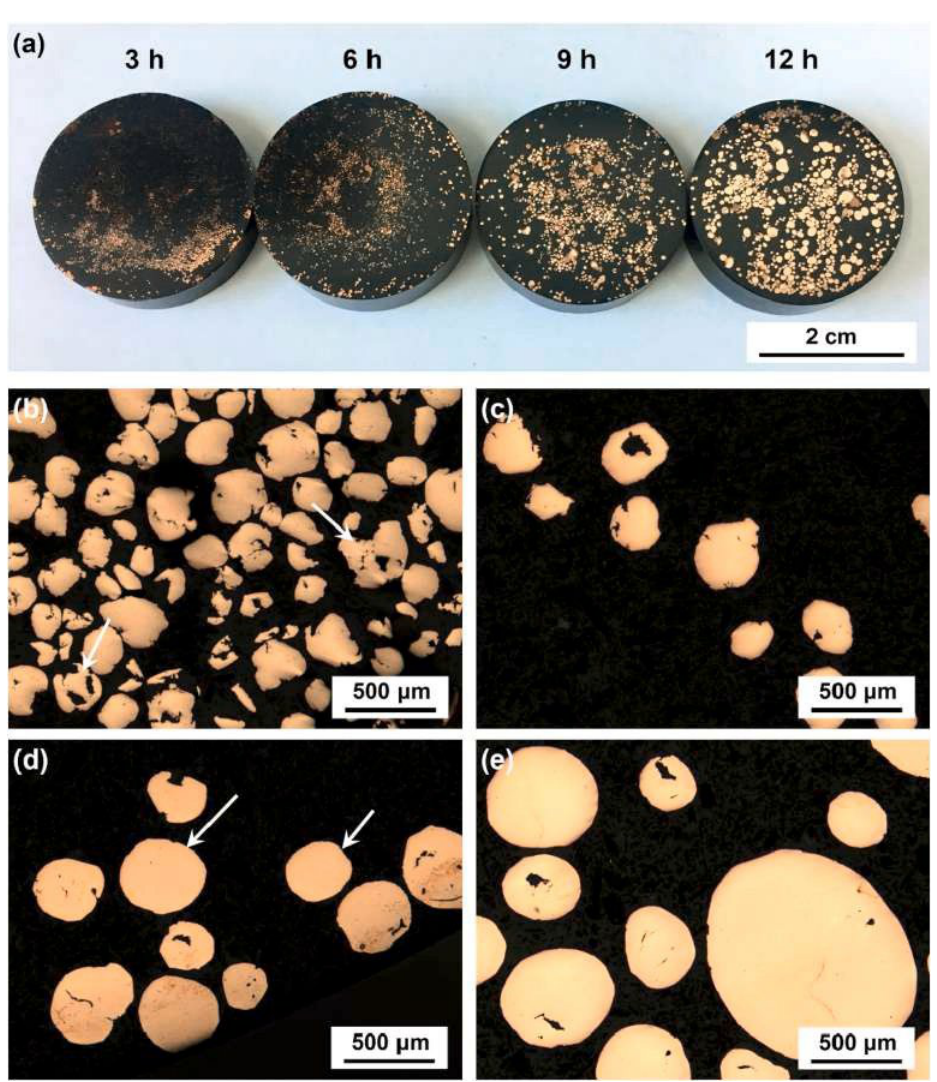
Figure 24. ( a ) The optical photograph of 3MXene-Cu composite powders embedded in bakelite with 3, 6, 9 and 12 high-energy ball milling, ( b – e ) the optical microscope photograph corresponding to the composite powder in ( a ): ( b ) 3 h, ( c ) 6 h, ( d ) 9 h and ( e ) 12 h, respectively [74]. After 9 h of grinding, a few bigger grains with nearly no flaws can be seen, as indicated by the white arrows in Figure 24d. The plastic deformation and cold-welding processes further thoroughly conducted when the milling duration was increased to 12 h.